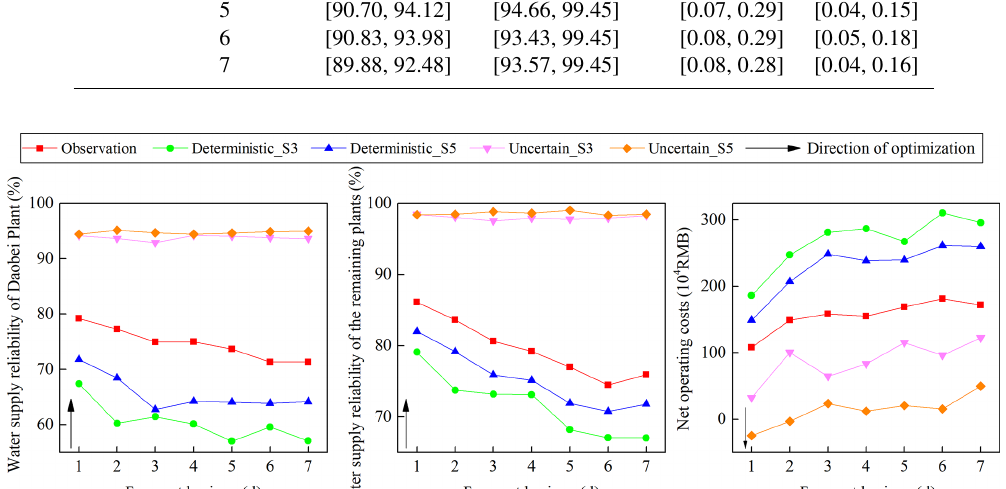
Figure 16. Annual system performance with different forecast horizons.